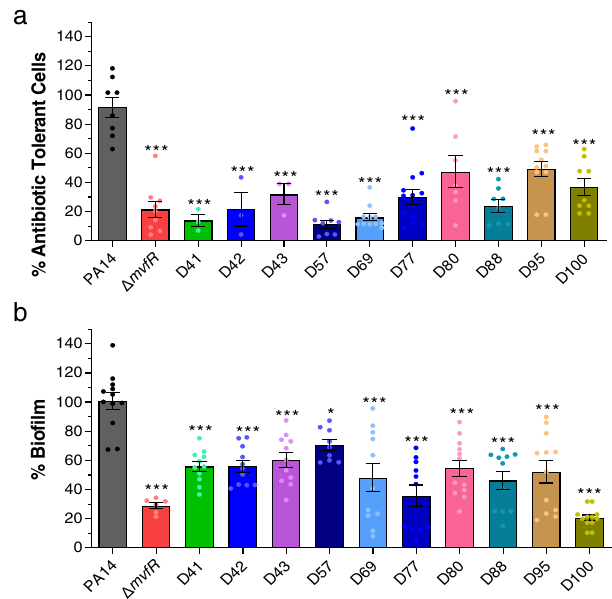
Fig. 3 | NAMs are potent agents against the formation of antibiotic tolerant, persisters (AT/P) cells and bio fi lm. a AT/P cells formation in PA14 and isogenic Δ mvfR inthepresenceorabsenceoftheindicatedcompounds.Cellsweregrownin the presence of 10 μ gmL − 1 meropenem with or without 10 µ M of the compounds for 24h. Values were normalized to the cells grown for 4h in the absence of anti- biotics and compound. The PA14 cells grown with antibiotics and vehicle (DMSO) were considered control, and the percentage values were calculated compared to control. b Initiation of bio fi lm formation of PA14 and Δ mvfR cells with or without compound. Bio fi lm was grown in the 96 well microtiter plate at 37°C for 24h containing M63 minimal media in the presence of 10 µ M of the compounds or vehicle. After 24h, the wells were washed to remove planktonic cells, and the bio fi lm was stained with 0.1% crystal violet. The stained bio fi lm was washed and solubilized in ethanol: acetone (80:20). OD was measured at 570nm. The bio fi lm grown with the vehicle was considered as a control. The percentage value was calculated in comparison to the PA14 control. a , b Data represent at least n =3 biological replicates, each dot on the graph represents one replicate, and the number of biological replicates for each compound is depicted in the graph. The errorbarsdenote±SEM.One-wayANOVAfollowedbyTukeypost-testwasapplied. ∗ , ∗∗ and ∗∗∗ indicate signi fi cant differences from the control at P <0.05, P <0.01, and P <0.001,